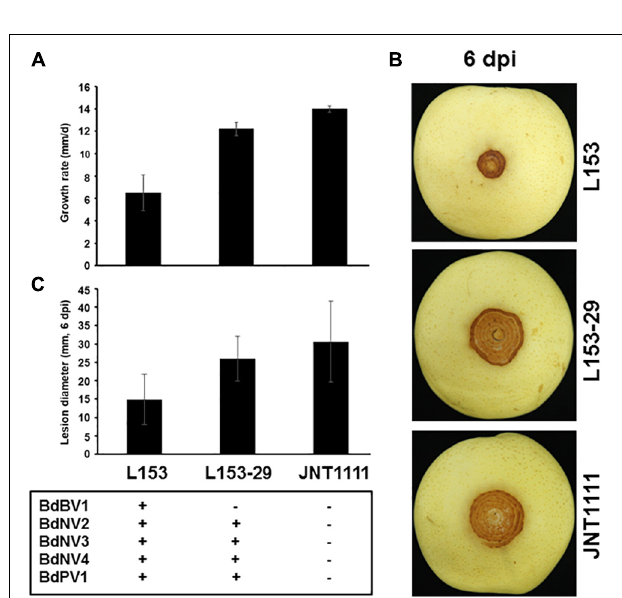
FIGURE 4 | Effects of BdBV1 infection on fungal growth and virulence. (A) Growth rates of strains L153, L153-29, and JNT1111 on PDA 25 ◦ C. (B) Pear fruits ( P. Brettschneider cv. Huang guan) wound-inoculated with colonized plugs of fungal strains. (C) The average diameter of lesions induced on pear fruits. The presence of BdBV1, BdNV2–4, and BdPV1 in these isolates is indicated below the histograms. Symbols “+” and “ − ” represent the presence and absence of these viruses based on the results of RT-PCR amplification and dsRNA